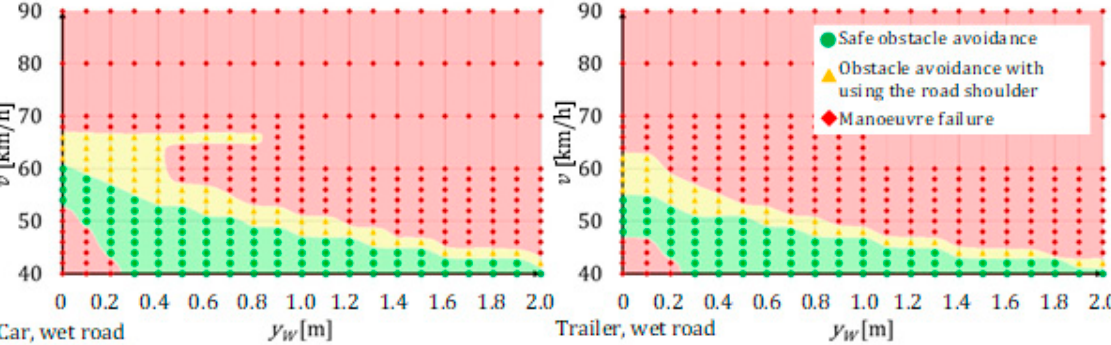
Figure 23. Area of choosing the y W values when planning a vehicle trajectory for safe obstacle avoidance on wet road surface; motorcar and trailer. Table 3. Possibilities of safe avoidance of the